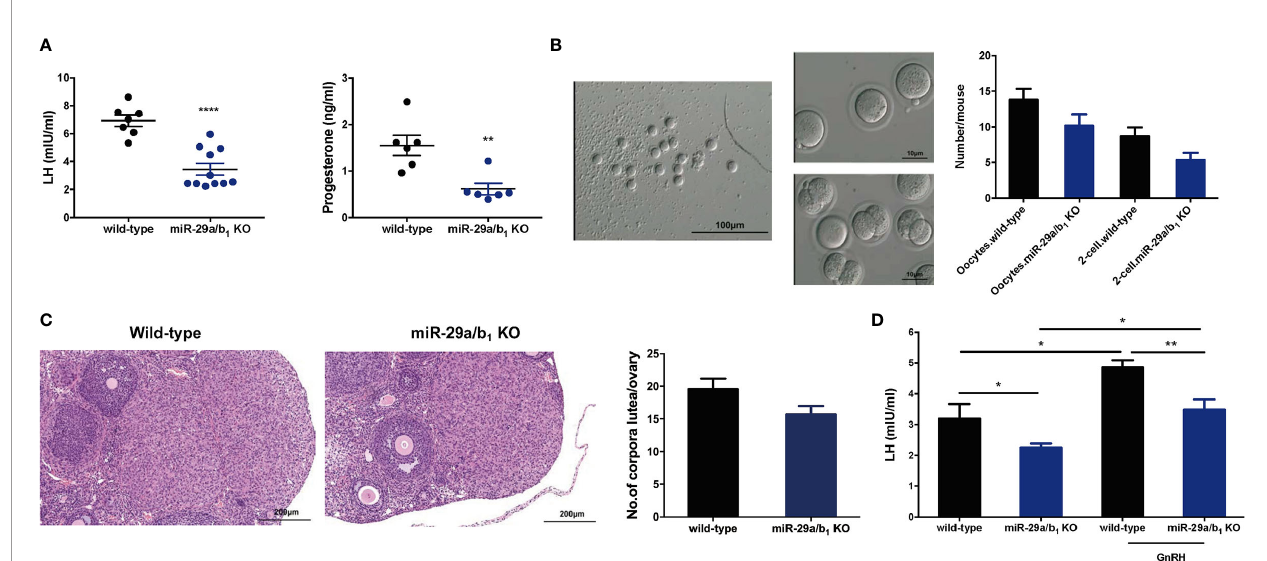
FIGURE 4 | Superovulation rescues the failure in corpora lutea formation in miR-29a/b 1 KO mice. (A) Serum LH (left) and progesterone (right) levels were signi fi cantly reduced in miR-29a/b 1 KO compared to wild-type mice (LH: wild-type: 6.927 ± 0.4062 mIU/ml, miR-29a/b 1 KO: 3.607 ± 0.5175 mIU/ml, p =0.0003, n=7; progesterone: wild-type: 8.166 ± 2.072 nmol/L, n=7, miR-29a/b 1 KO: 1.062 ± 0.1181 nmol/L, n=6, p=0.0092 ). (B) Numbers of oocytes and 2-cell embryos obtained in response to superovulation in miR-29a/b 1 KO and wild-type mice (Oocytes: wild-type: 13.83 ± 1.493, miR-29a/b 1 KO: 10.17 ± 1.558, p=0.1201 ; 2-cell embryos: wild-type: 8.667 ± 1.256, miR-29a/b 1 KO: 5.333 ± 1.022, p=0.0666 , n=6). (C) Corpora lutea formation in ovaries of miR-29a/b 1 KO females after superovulation (wild-type: 19.56 ± 1.634, miR-29a/b 1 KO: 15.67 ± 1.302, p=0.0811 , n=9). (D) GnRH challenge in miR-29a/b 1 KO and wild-type mice (wild-type: 3.19 ± 0.48 mIU/ml, miR-29a/b 1 KO: 2.255 ± 0.1287 mIU/ml, p=0.0376 , n=5; GnRH: wild-type: 4.857 ± 0.2346 mIU/ml, p=0.0138 , n=6, miR-29a/b 1 KO : 3.484 ± 0.3357 mIU/ml, p=0.0145 , n=7). * p < 0.05, ** p < 0.01 and **** p <